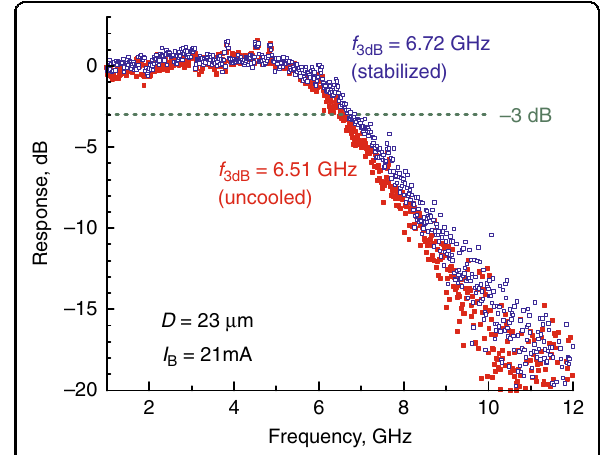
Fig. 14 Direct modulation of microdisk laser. Small-signal frequency response of QWD-on-GaAs microdisk laser operating uncooled ( fi lled symbols) or with temperature stabilization (open symbols) f 3dB - modulation bandwidth, I B - bias current, D - disk diameter